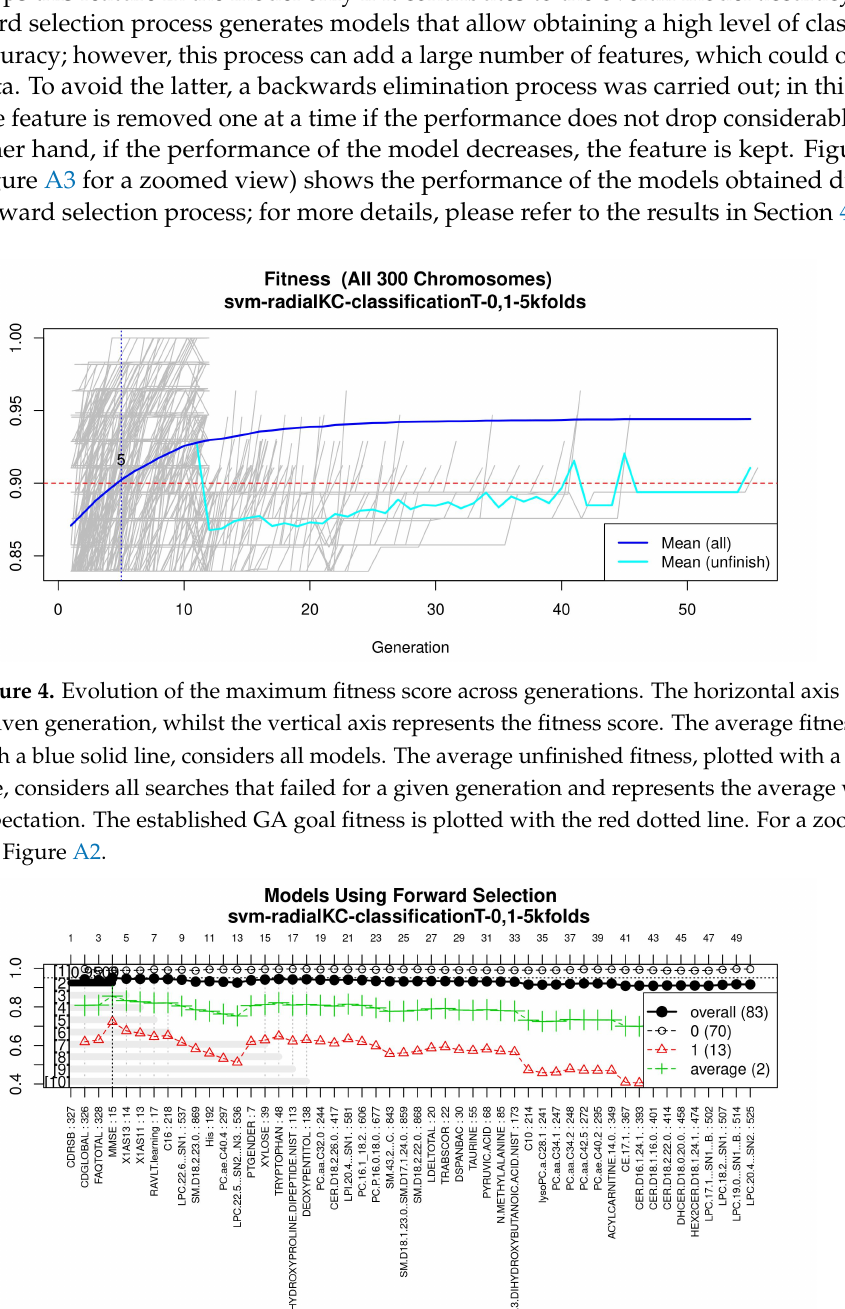
Figure 5. Performance of the most compact and accurate models after using the forward selection methodology. The horizontal axis represents the features ordered by rank. The vertical axis shows the classification accuracy. For a zoomed view see Figure